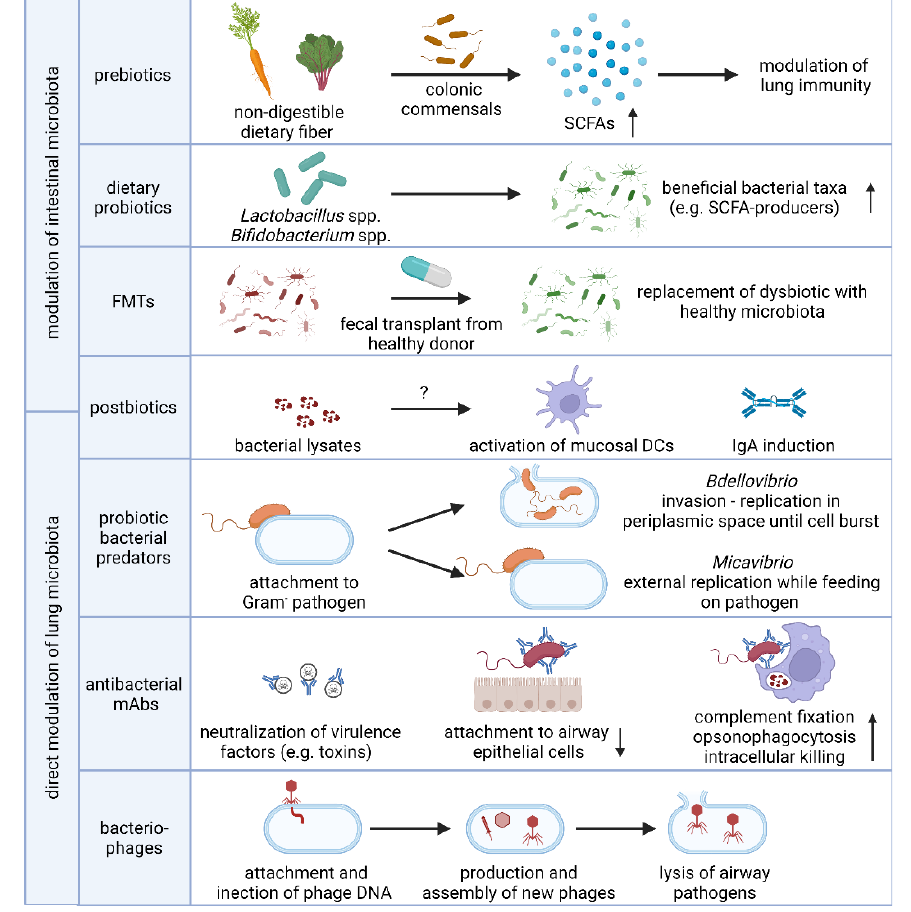
Figure 2. Microbiome-based strategies to prevent and treat respiratory disease. Modulation of the composition and/or activity of the intestinal microbiota to promote lung immunity aids in the defense against respiratory bacterial infections and management of chronic lung disease. Intake of non-digestible dietary fiber drives the production of the bioactive SCFA metabolites by colonic commensal bacteria while the use of probiotics aims to modify the composition of the microbiome towards beneficial bacterial taxa, including SCFA-producers. The precise immunomodulatory mechanism of intranasally or orally administered postbiotics remain elusive but may be in part due to mucosal DC and IgA induction. In addition, the lung microbiota can be directly modulated by selectively eliminating bacterial pathogens using probiotic predatory bacteria, antibacterial human mAbs or strain-specific bacteriophages. Abbreviations: SCFAs, short-chain fatty acids; FMT, fecal microbiota transplant; DC, dendritic cell; IgA, immunoglobulin A; mAb, monoclonal antibody. Figure created with BioRender.com.